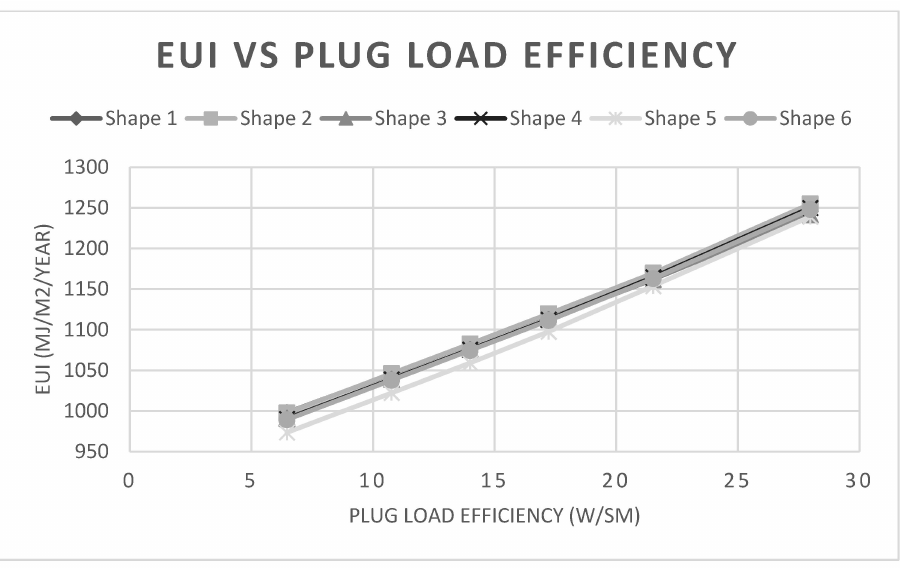
Figure 12. EUI of shapes vs. plug load efficiency.